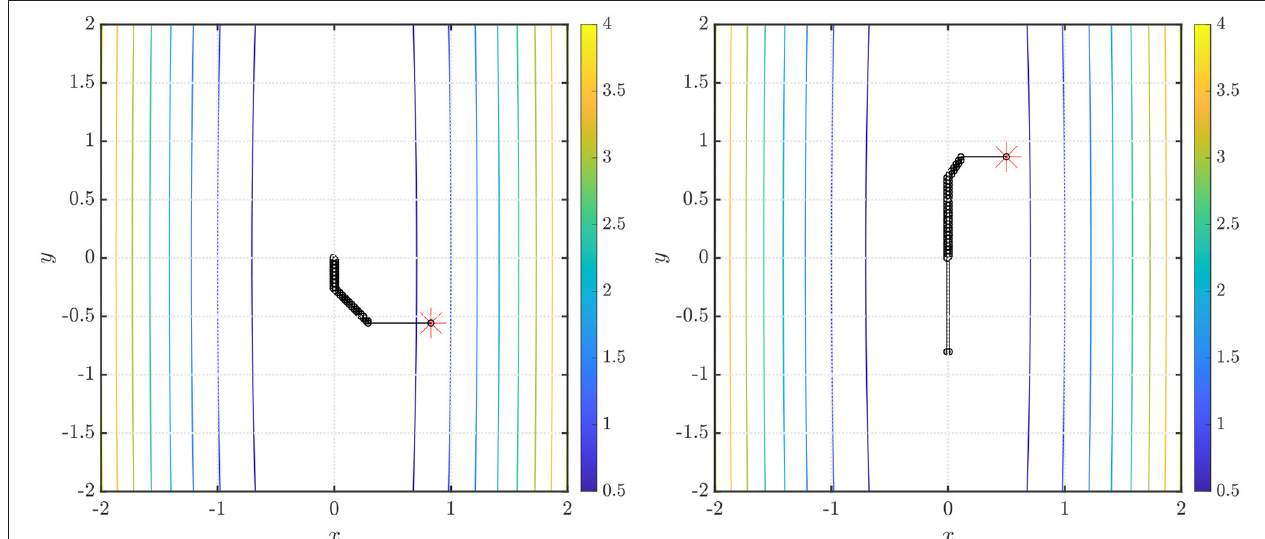
x 2 0.01 y 2 . The initial = +